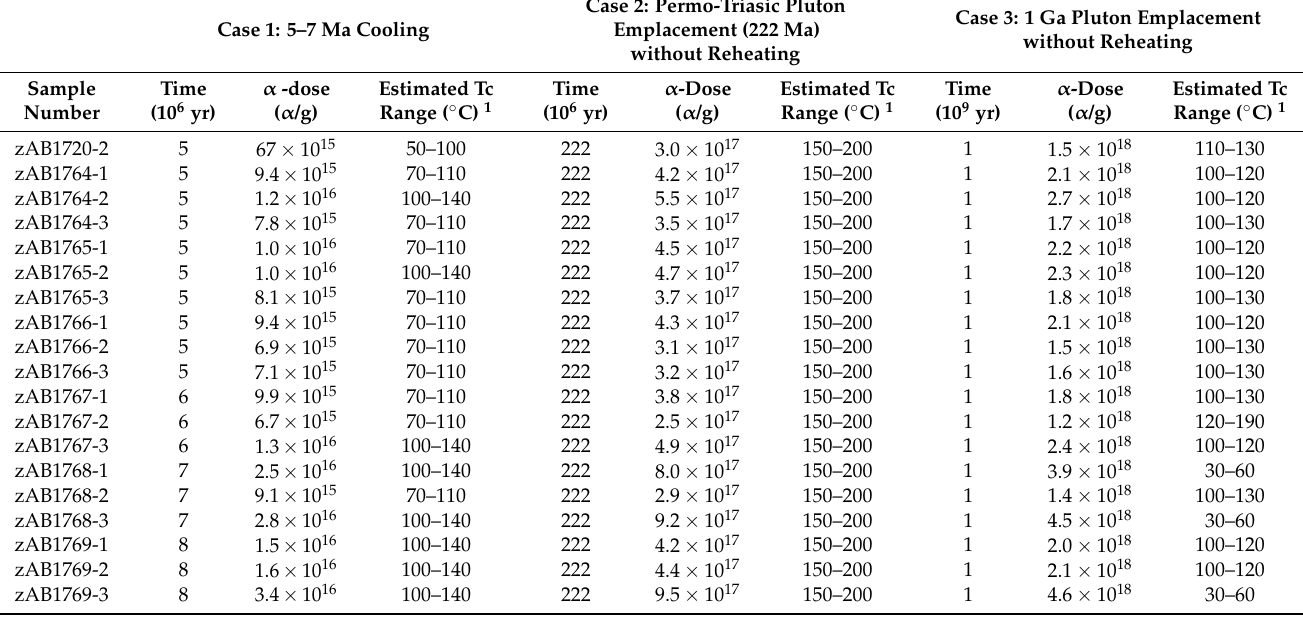
Table 4. Closure temperature (Tc) estimation with a scenario implying rapid cooling initiated between 5 and 7 Ma (case 1) and a simple scenario where the α -dose received is only due to the age of the Permo-Triasic, pluton 222 Ma; [23], (case 2) or of a >1 Ga pluton (case 3). Tc is estimated for each aliquot by reporting the computed α -dose for each case in Figure